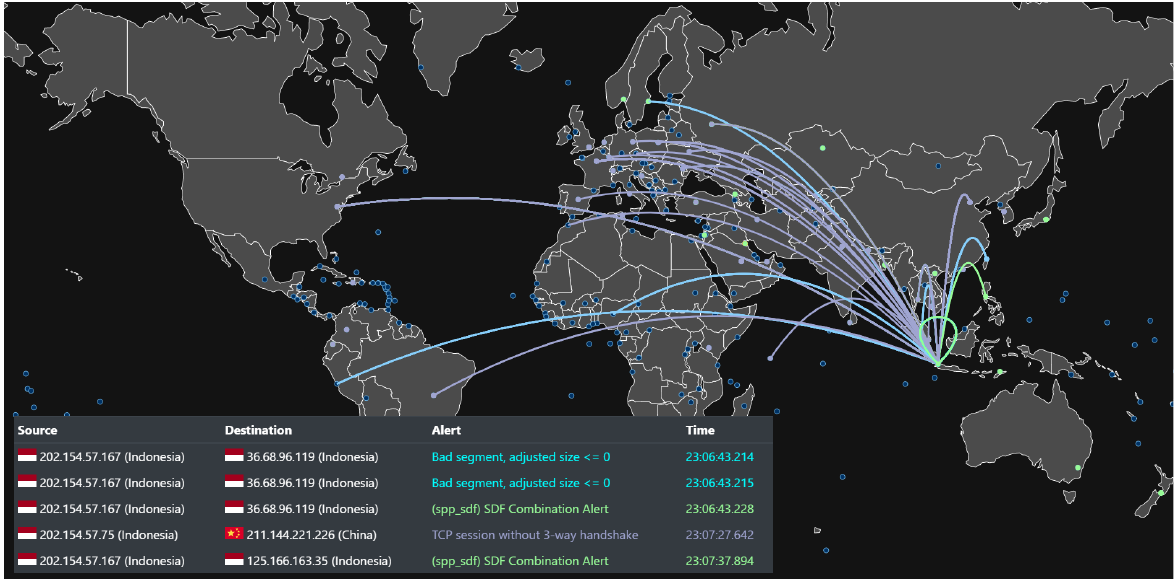
Figure 10. The client web page shows the attacks maps.